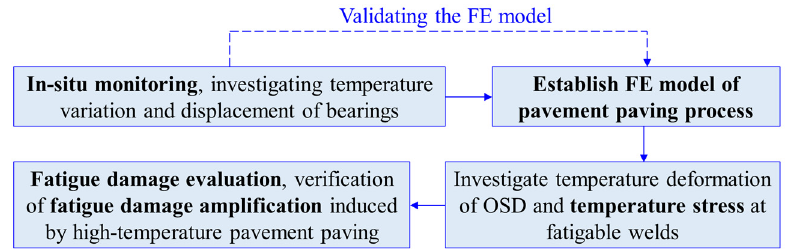
Figure 2. Research flow chart.